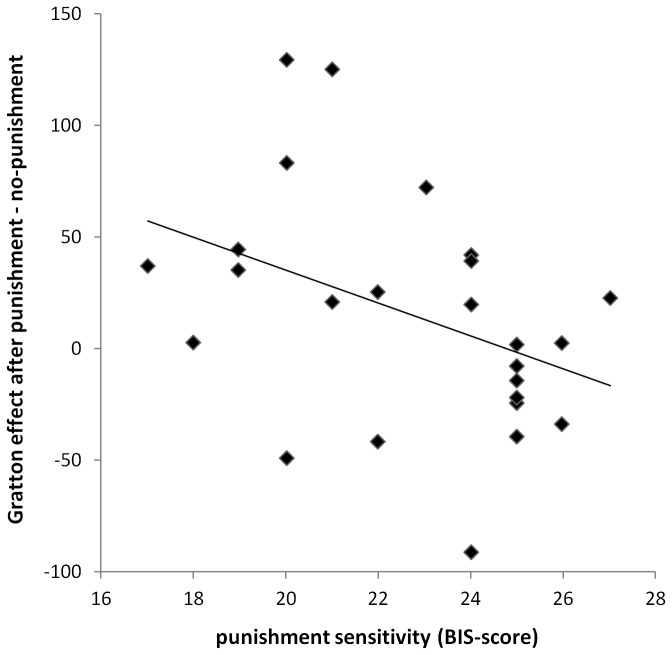
The scatter plot shows the correlation between individual scores on the BIS scale and the difference scores for the Gratton effects.